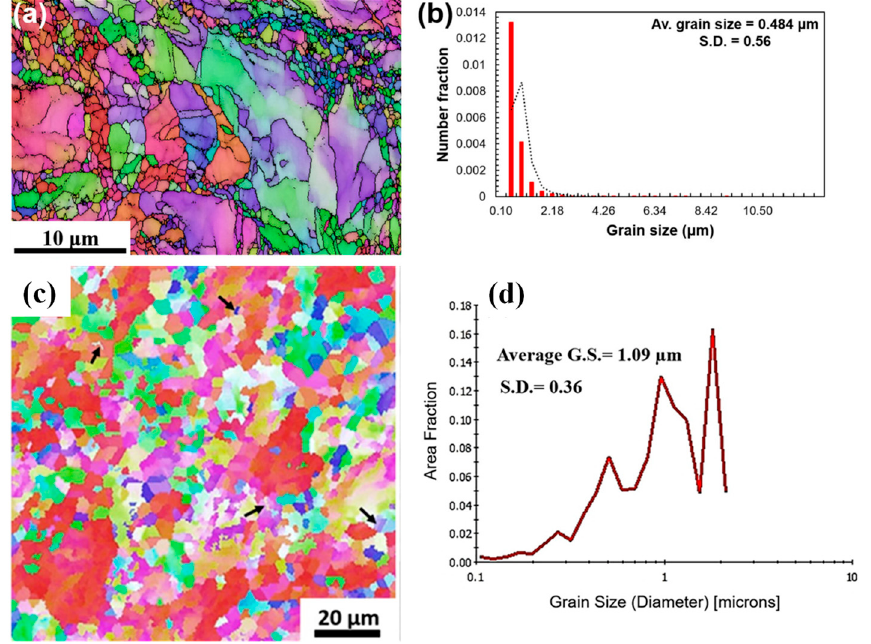
Figure 12. Microstructure of 4-pass pure titanium at different temperatures and grain size distribu- tion:( a , b ) at 450 °C [78]. Reproduced with permission from Springer Nature. ( c , d ) at 400 °C [77]. Reproduced with permission from Elsevier B.V.